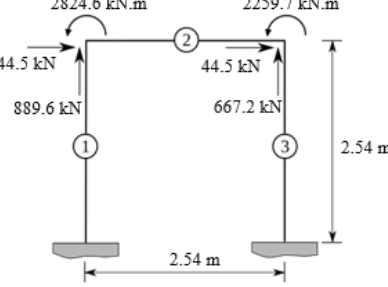
Figure 2. Plane frame